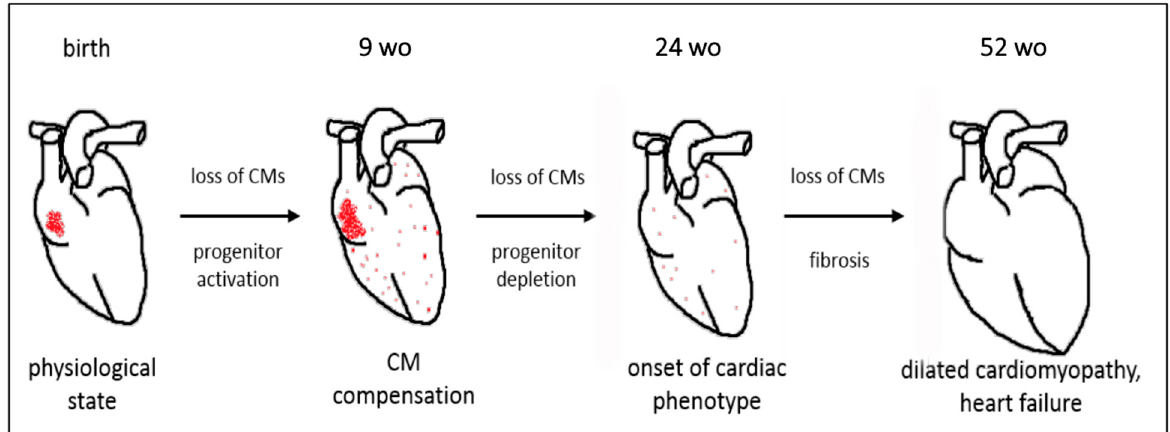
Figure 7. Diagram of the proposed mechanism for the fate of CVPCs in the dystrophin-deficient heart. Dystrophin deficiency induces CVPC proliferation and hyperplasia in 9 wo mdx mice associated with an age-dependent depletion and simultaneous progressive fibrosis of the heart during ageing leading to development of cardiac dysfunction by 52 wo.